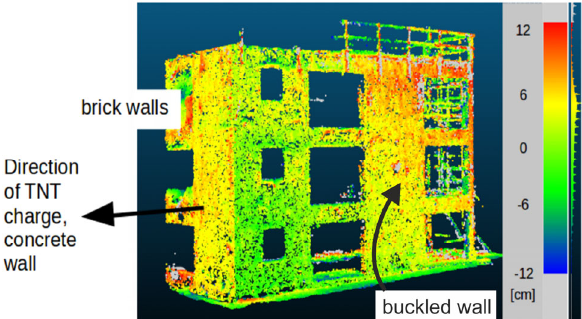
Figure 3. UAV-derived point clouds of reinforced concrete structure with brick in-fill walls subjected to exterior and interior detonations. Openings, cracks and debris piles were automatically detected, and also subtle deformation in the façades were detected.